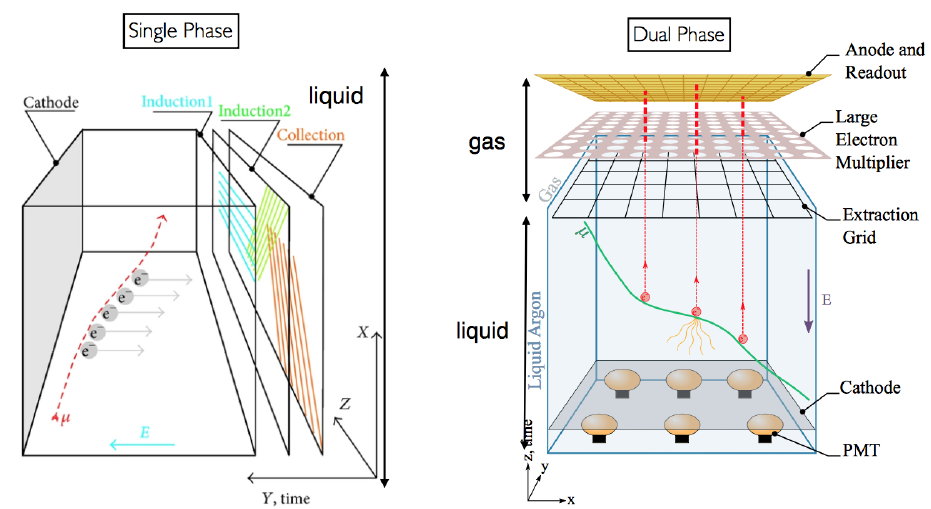
Figure 2: Schematic view of the operating principle of the DUNE Single-Phase (left) and Dual-Phase (right) liquid argon